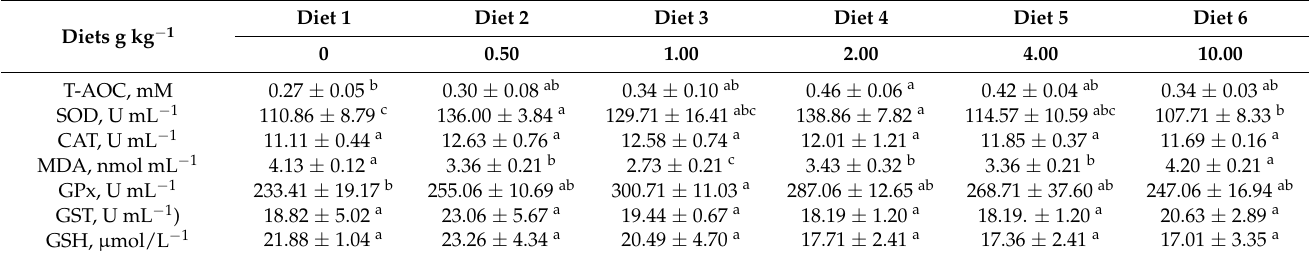
Table 8. Effects of ELE on antioxidant abilities of the hemolymph in Cherax quadricarinatus